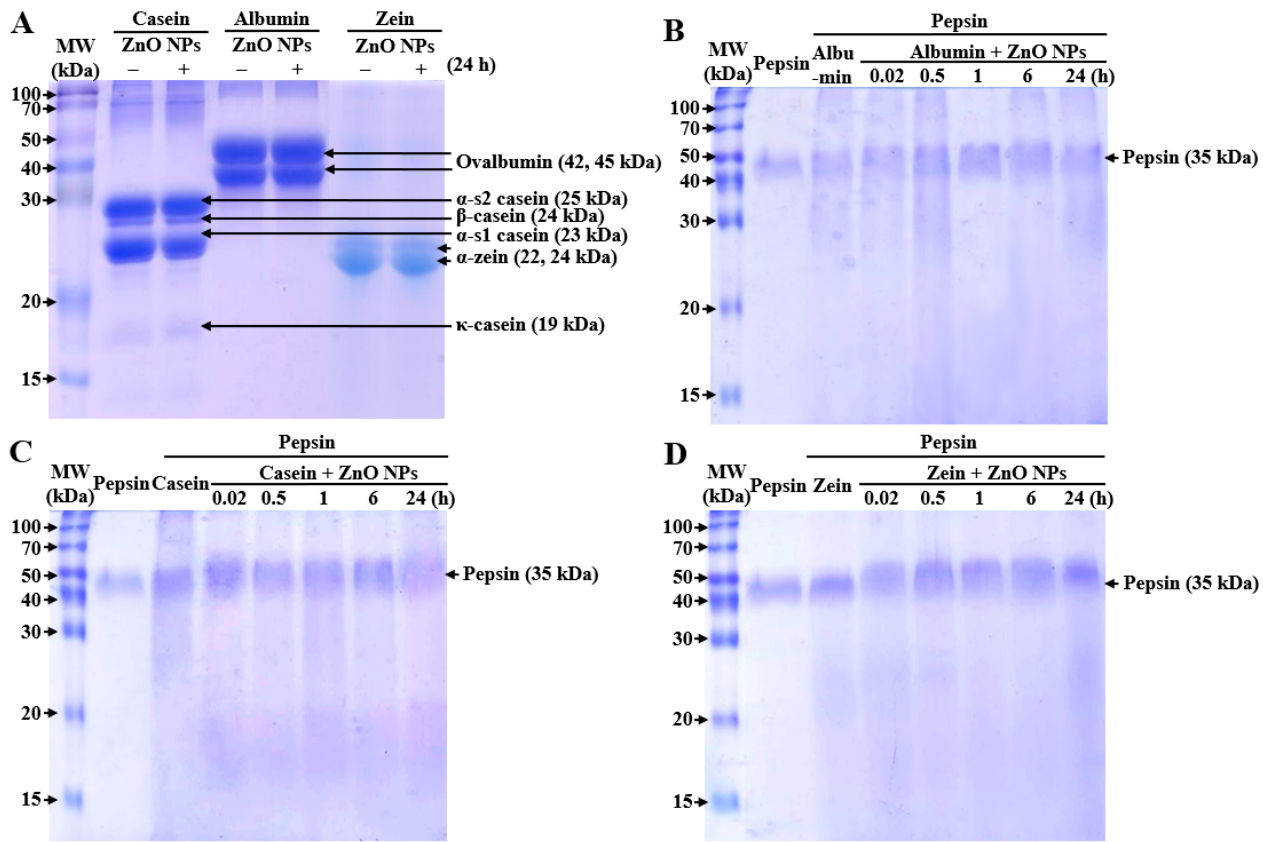
Figure 4. Sodium dodecyl sulfate–polyacrylamide gel electrophoresis (SDS–PAGE) of ( A ) food proteins interacted with ZnO NPs for 24 h, and ( B ) albumin, ( C ) casein, and ( D ) zein by interactions with ZnO NPs followed by pepsin treatment for 1 h. MW, molecular weight.